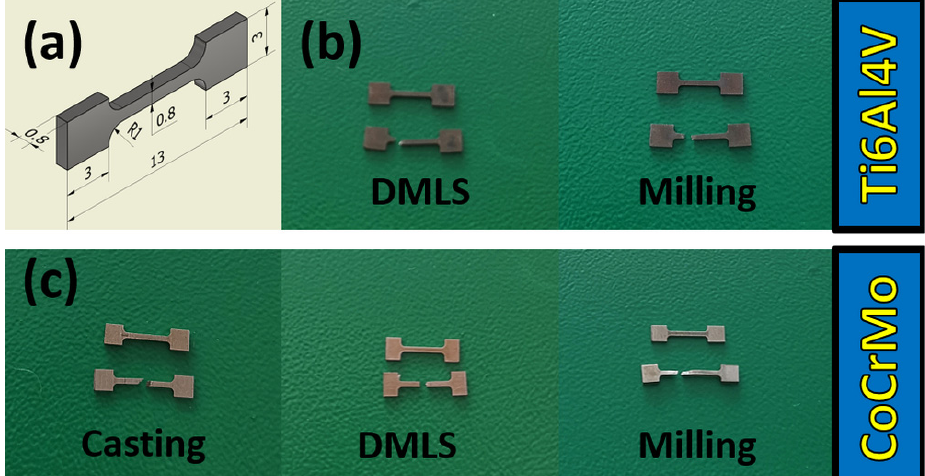
Figure 2. Material for tensile strength tests: ( a ) CAD model of the test sample; ( b ) Ti6Al4V alloy samples before and after the test; ( c ) CoCrMo alloy samples before and after the test.